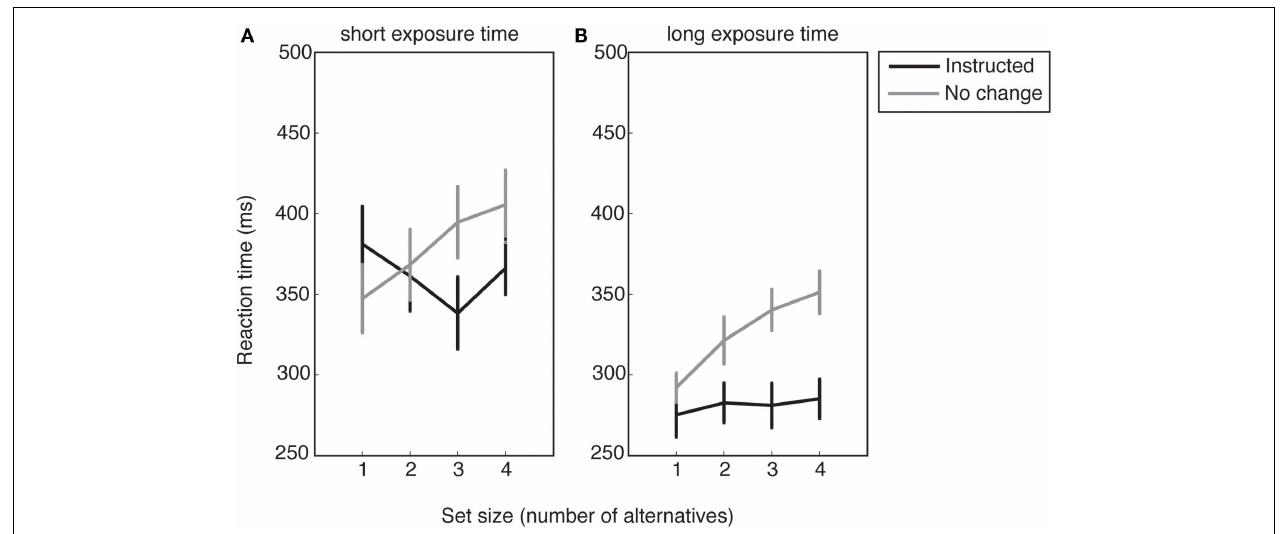
FIGURE 4 | Reaction times as a function of response set size for (A), short exposure time trials and (B), long exposure time trials. Error bars show standard error of the mean.